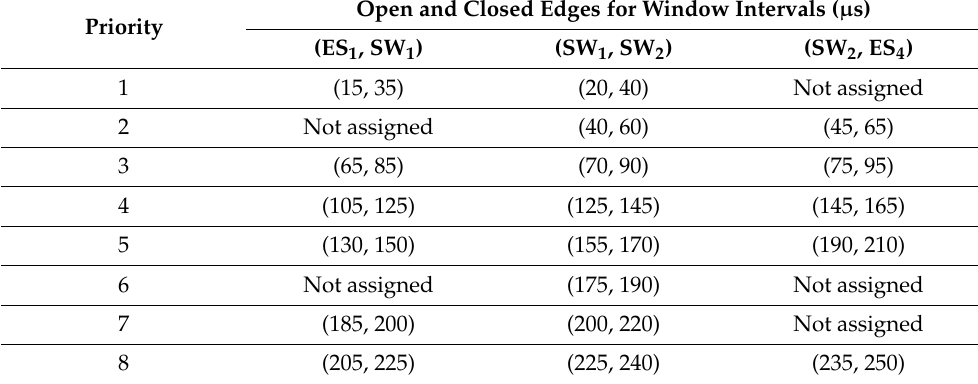
Table 2. The initial GCL